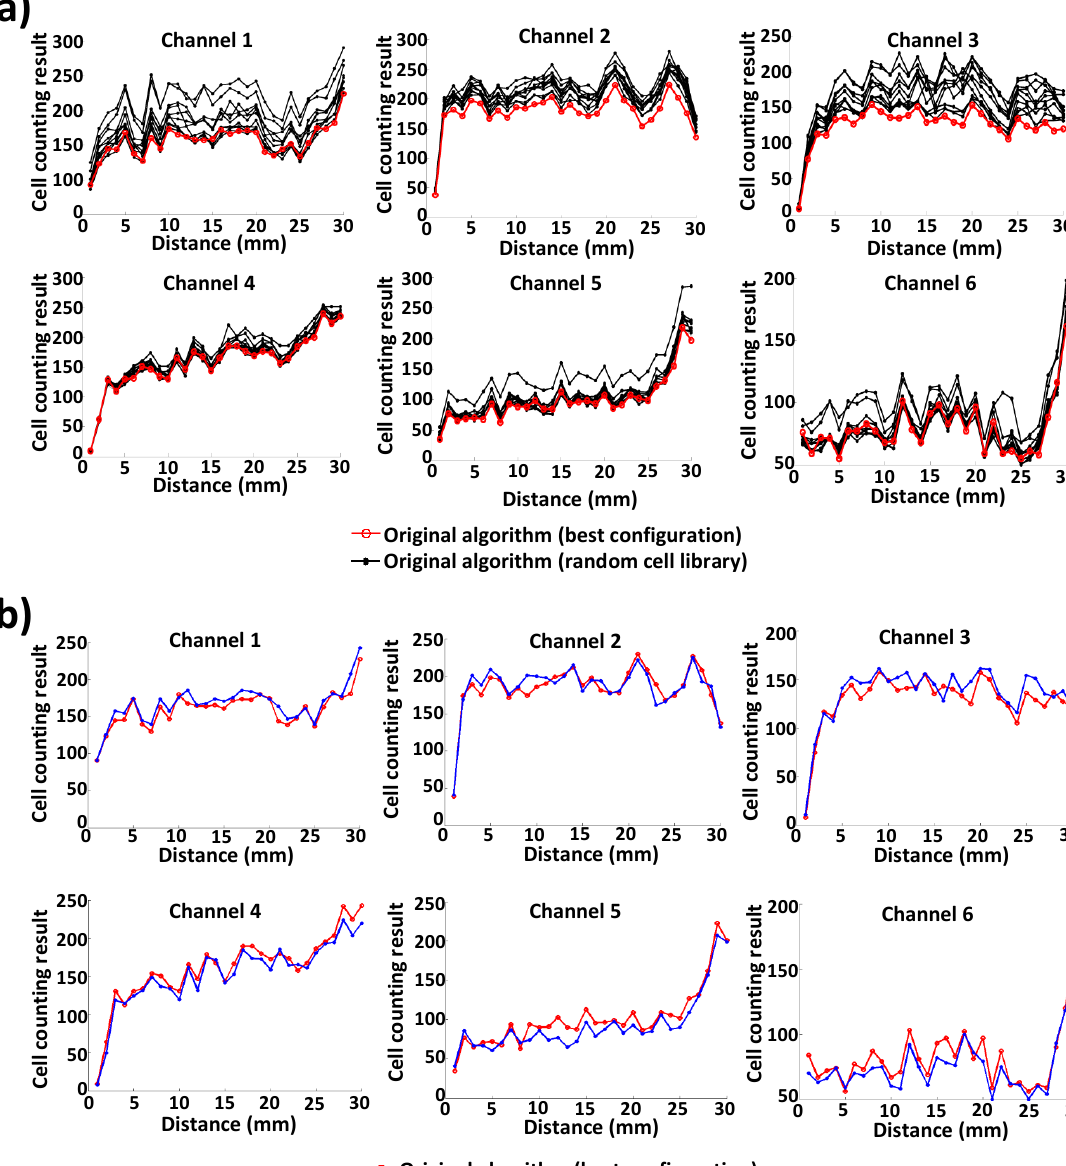
Figure 6. Evaluation of the counting accuracy of the original and optimized algorithms. ( a ) For each of six channels, 10 count results of the original algorithm, each with its own randomly-selected cell image library, are plotted based on the distance (up to 30 mm) from the inlet port of each channel; the count result of the original algorithm that yields the best match with manual counting is plotted, as well. In the original algorithm (using 150 random cell images), the number of counted cells varies a lot (up to 30%), due to the random generation of cell image library for each execution. ( b ) The counting results of the original algorithm (best configuration) and the optimized algorithm (via cross-validation) are compared. For each of the channels, a specific cell image library for the optimized algorithm is generated by using the rest of five channel images to conduct cross-validation. The optimized algorithm exhibits an average difference of 5.05%. This demonstrates the robustness and effectiveness of the proposed